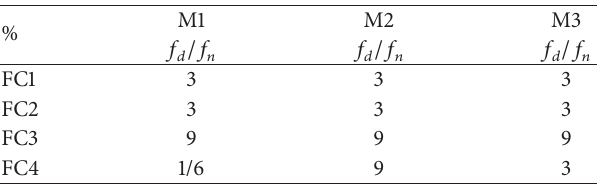
Table 4: Comparison of the dominant frequencies at the points in the front